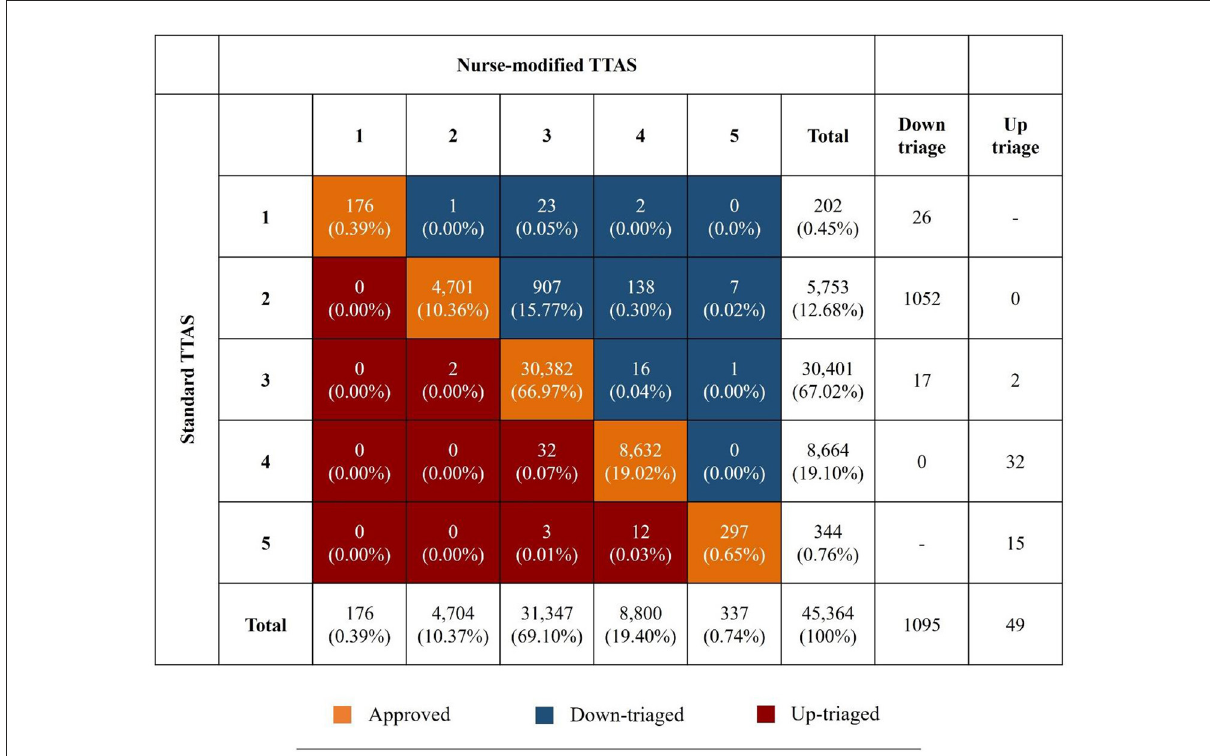
FIGURE2 Acuity level distributions of the TTAS before and after triage nurses’ modification. TTAS, Taiwan Triage and Acuity